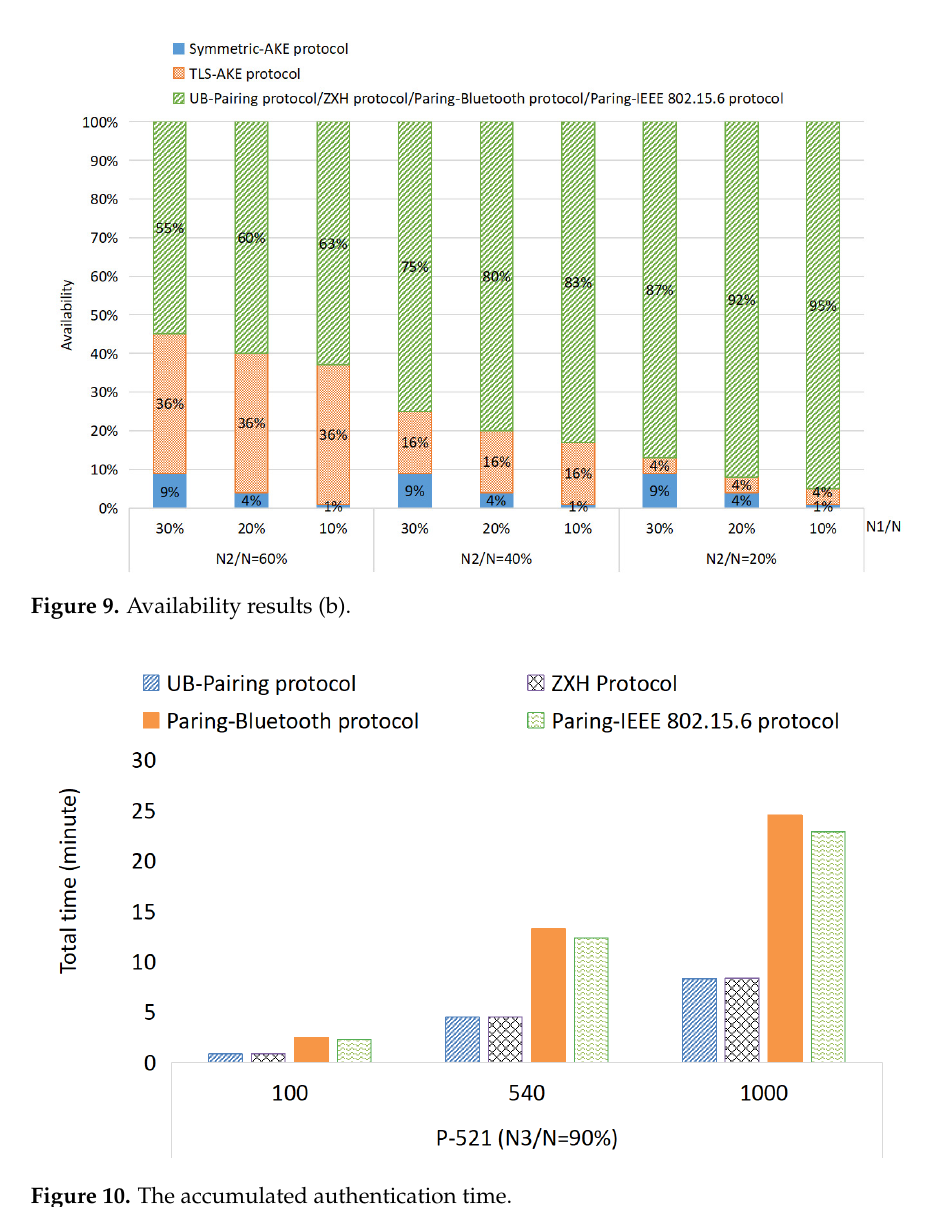
Figure 10. The accumulated authentication